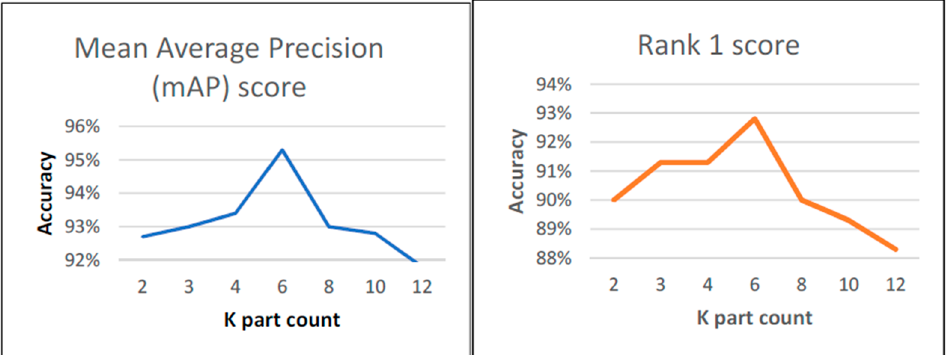
Figure 7. Analyzing the Effect of different K-Parts on the mAP and Rank1 score.